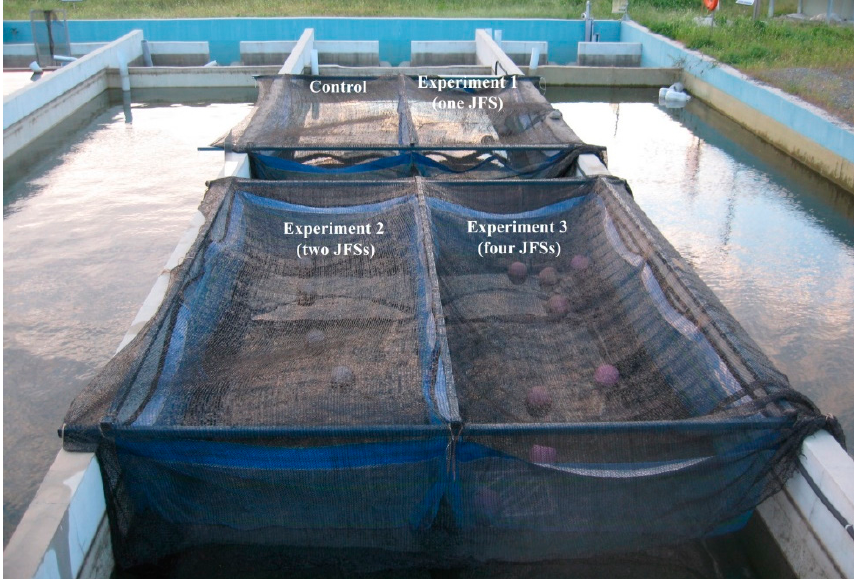
Figure 1. Pictorial view of large ‐ scale mesocosm experiments with different number of JFSs.